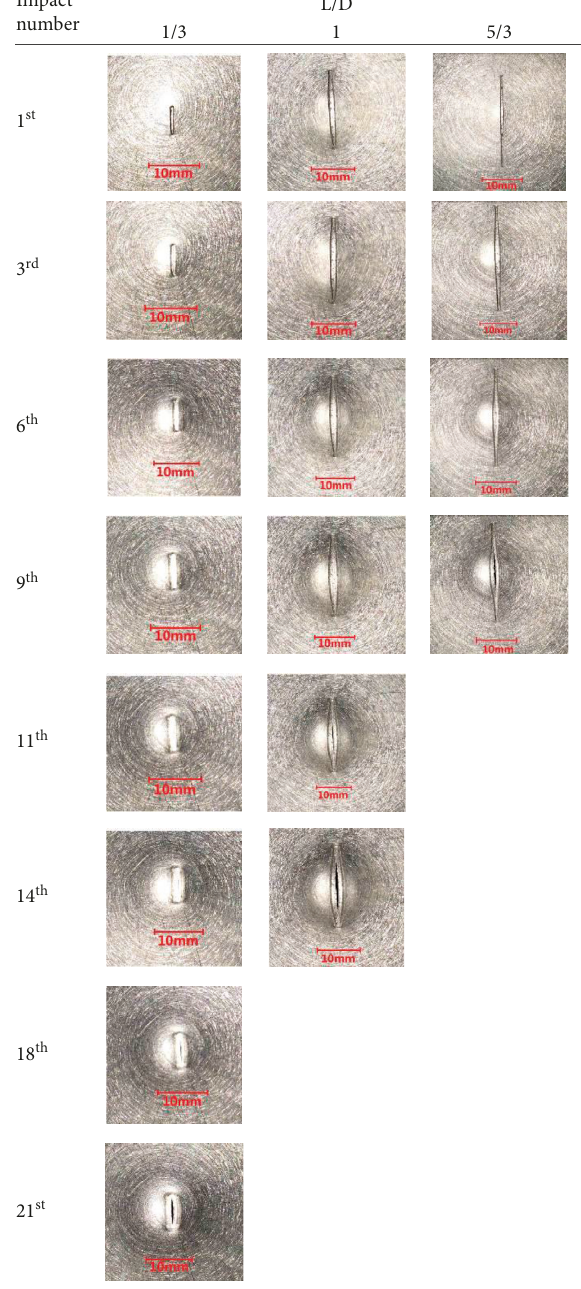
Figure 11: Deformation mode under repeated impacts at room temperature.